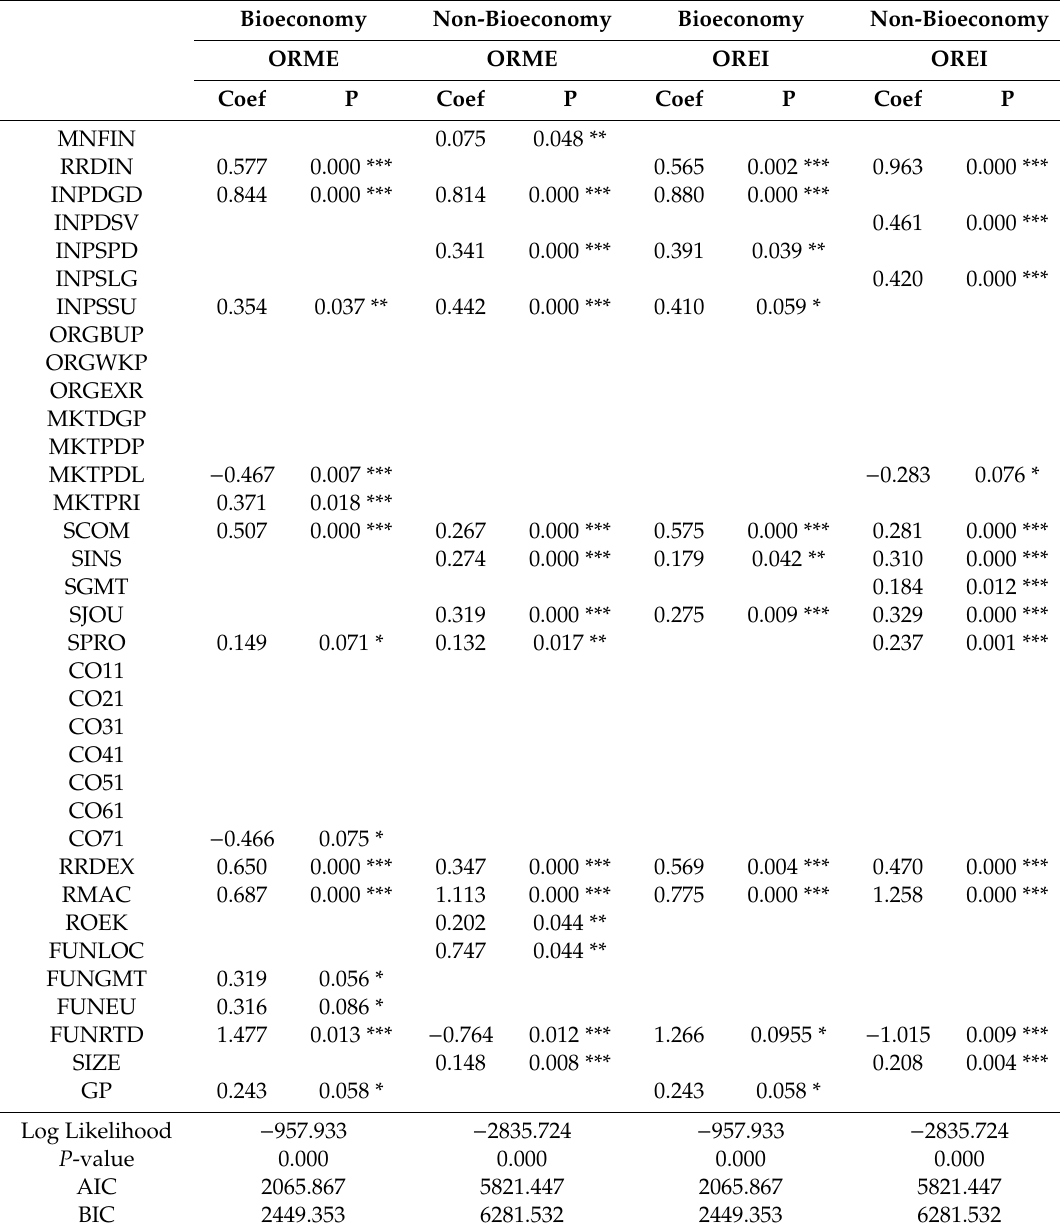
Table A5. Estimation results of multivariate tobit model